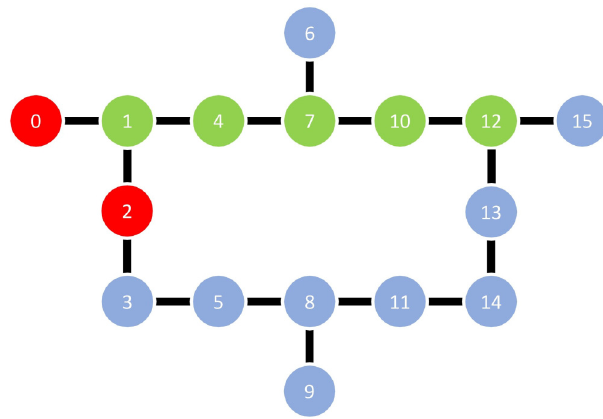
FIG. 6. The topology of IBMQ_GUADALUPE with 16 qubits. The links denote the possibility of implementing a direct two- qubit gate between a pair of qubits. The red (green) qubits are employed as system (ancillary) qubits in the simulation of dissipative collective effects.